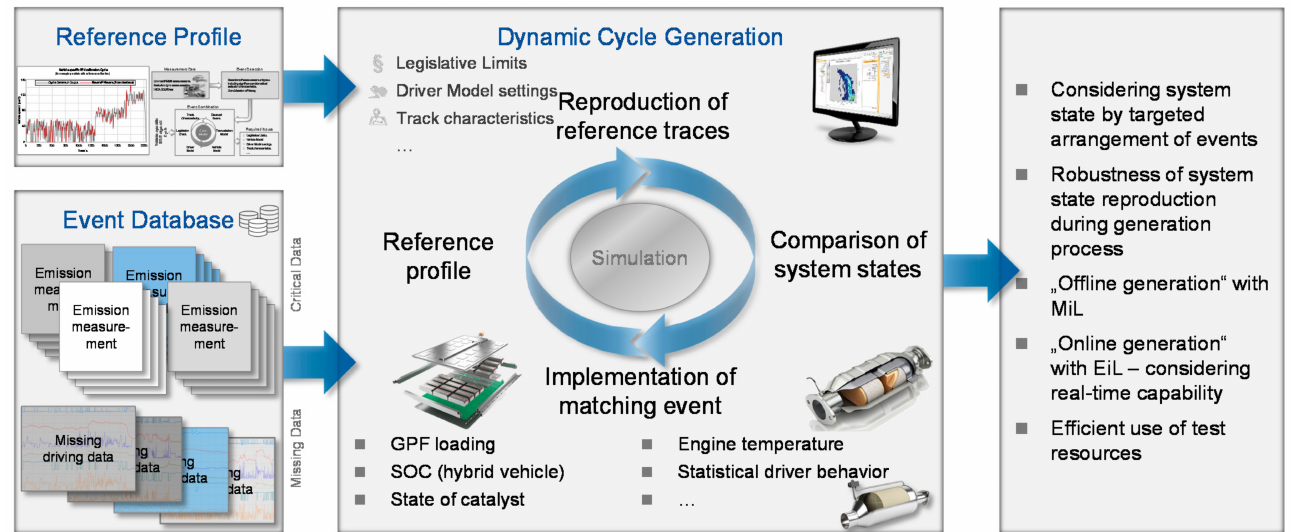
Figure 11. Procedure of dynamic and model predictive cycle